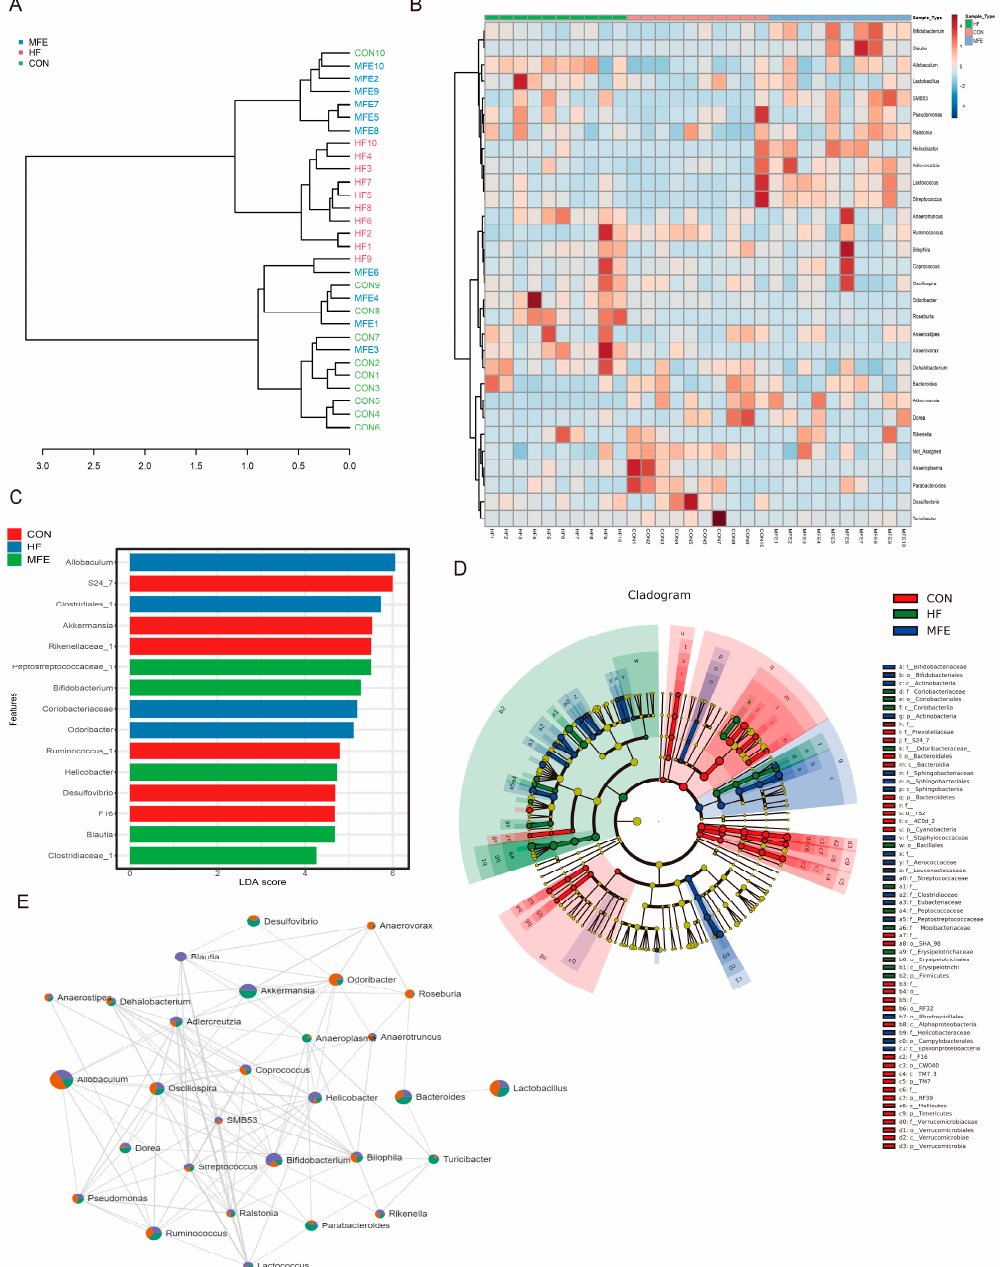
Figure 3. Correlation and difference analysis of intestinal flora via MFE in mice fed a high ‐ fat diet.